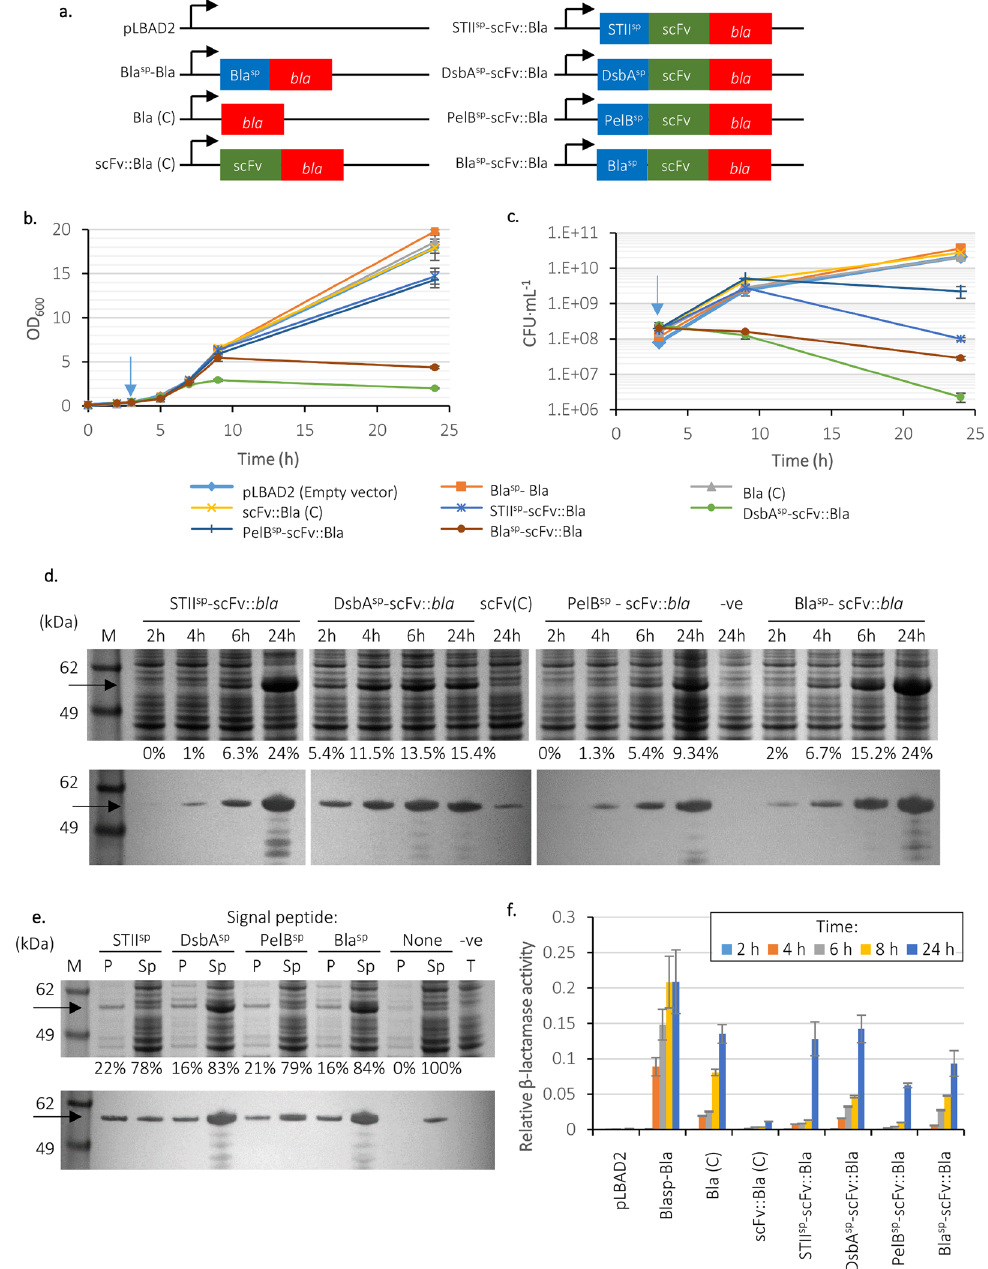
Figure 2. Construction and characteristics of signal peptide-scFv- β -lactamase constructs. ( a ) Plasmid constructs generated for the β -lactamase screening; signal peptide (blue), scFv 13R4 (green) and the bla reporter (red). Cytoplasmic versions of β -lactamase and scFv::Bla without a signal peptide are included as controls, marked as (C). E . coli BL21-A carrying the vectors in ( a ) were grown at 25 °C, induced with 0.02% of arabinose at an OD 600 ≈ 0.5 (blue arrow), and the OD 600 (b) and CFU (c) measured. Data are shown as mean values from replica flasks, error bars are ± 1 standard deviation. (d) Cells were harvested and analysed by SDS-PAGE and Western blotting (anti myc). The quantity of scFv::Bla is expressed as a percentage of whole cell protein at the bottom of the gel. Controls are scFv::Bla (C) and empty vector ( − ve). Percentages of total cell protein that was scFv are shown below the gel. (e) The periplasmic (P) and spheroplast (Sp) fractions of samples taken after 6 hours growth were separated and analysed by SDS-PAGE and Western blotting using anti-myc. Negative control is the empty vector (pLBAD2), total protein. Percentage distributions of scFv between periplasmic and spheroplast fractions are shown below the gel. (f) β -lactamase activity was determined using nitrocefin. Transformants were grown at 25 °C and induced with 0.02% arabinose after 2 hours growth; samples were taken at intervals and β -lactamase activity of whole cells was measured. Error bars represent the 5% uncertainty in the calculation of the slopes corresponding to β -lactamase activity (n = 3), which is expressed in terms of change in OD 495 per minute per OD 600 . Uncropped gel images are available in Supplemental Fig.